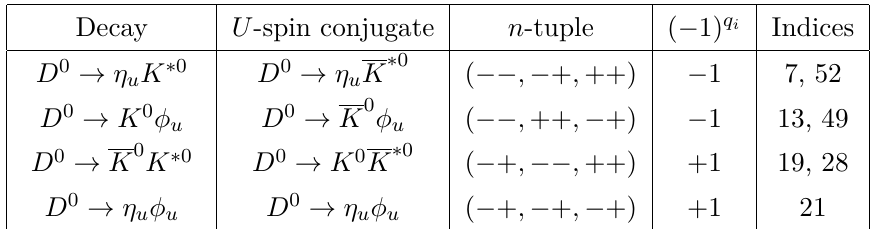
Table 6 . The mapping of the U -spin pairs of D 0 → PP ∗ decays into generalized n -tuples.